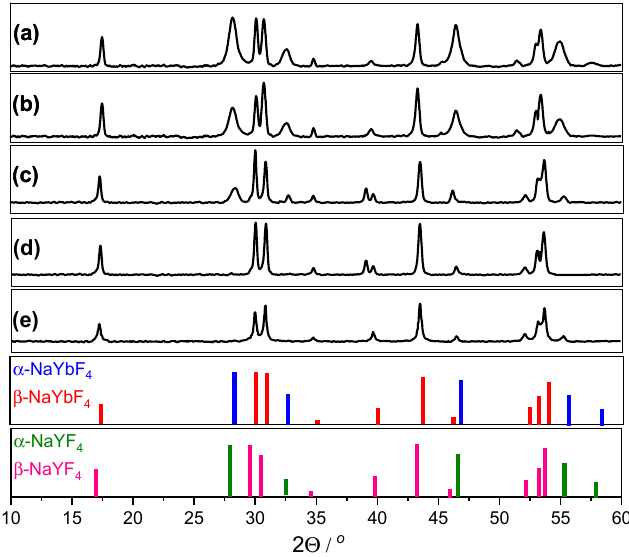
Figure 4. XRD patterns of ( a ) NaYb 0.99 F 4 :Tm 0.01 @NaYF 4 , ( b ) NaYb 0.99 F 4 :Tm 0.01 , ( c ) NaY 0.3 F 4 :Yb 0.69 Tm 0.01 ,